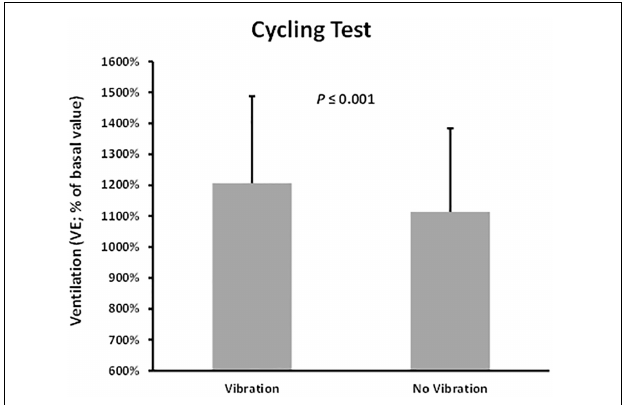
FIGURE 4 | Differences of relative ventilation with respect to basal value (%) between the vibration and no vibration conditions during graded maximal cycling